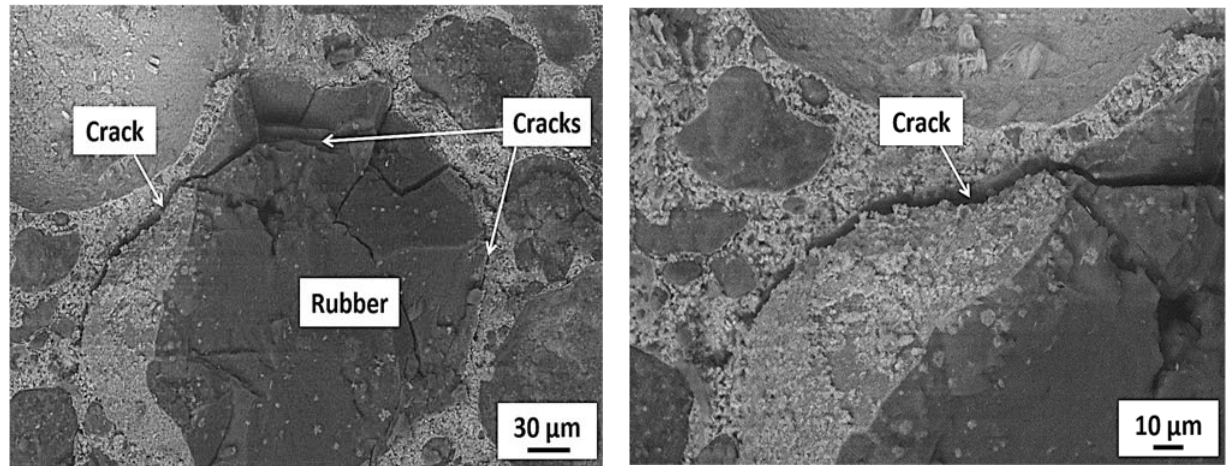
Figure 12. SEM image of control specimen incorporating RW.